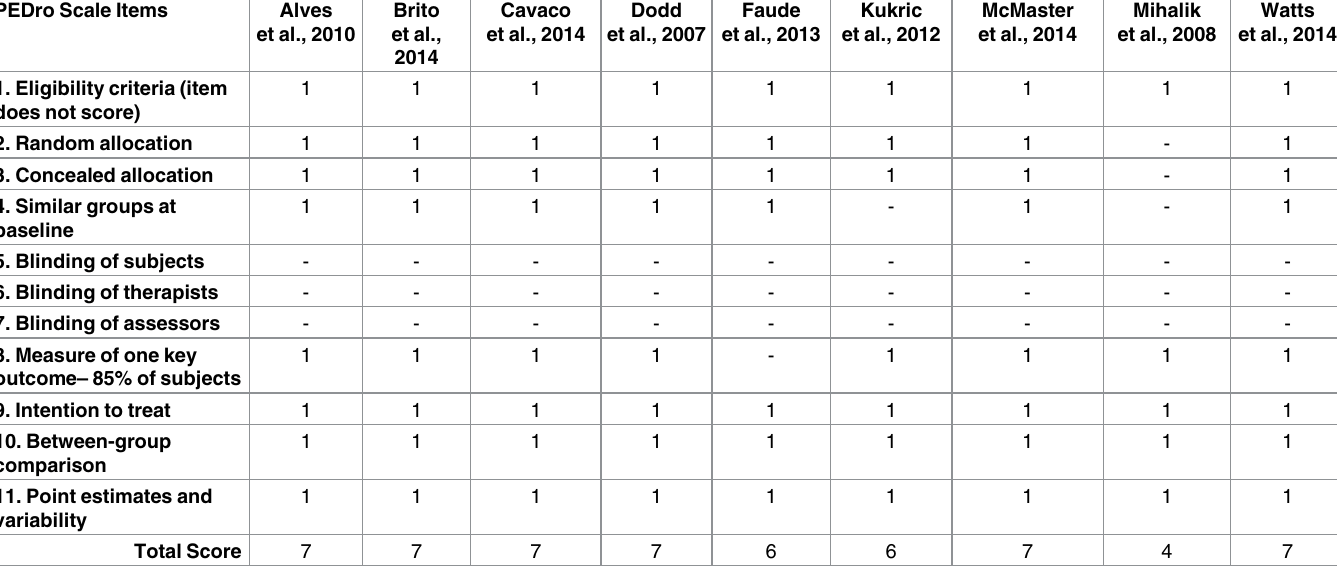
Table 1. PEDro scale scores of the studies included in the